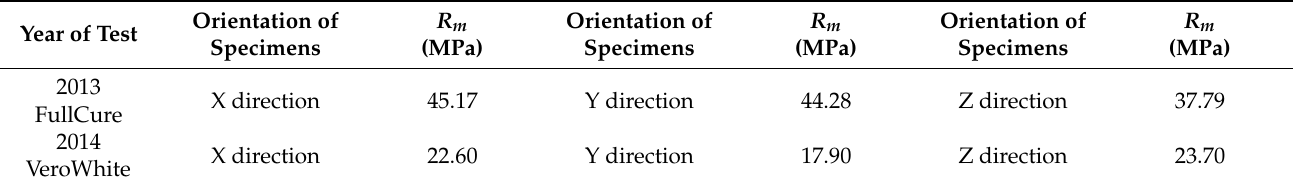
Table 3. Mean values of the tensile strength in MPa for FullCure 720 and VeroWhite models tested in 2013 and 2014,